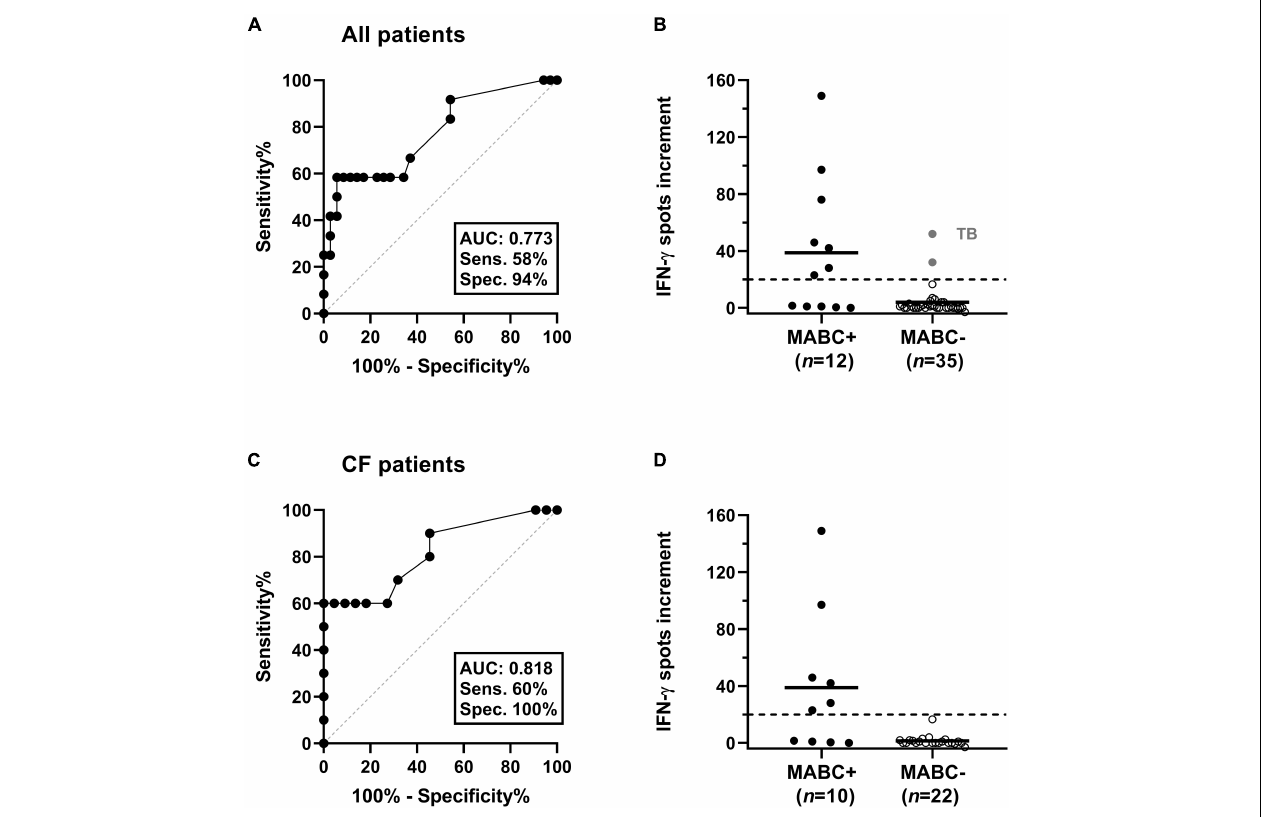
FIGURE 3 | Discrimination between patients with and without M. abscessus (MABC) infection. This analysis considered either all patients (A,B) or only patients with cystic fibrosis (CF) (C,D) . (A,C) Results of receiver operating characteristic (ROC) curve analyses. It was analyzed if ELISpot responses to the MAB_0405c protein were predictive of (culture-confirmed) MABC infection. (B,D) Responses of the MAB_0405c ELISpot are compared in patients with and without MABC infection (Mann–Whitney U test). Positive results in two patients with M. tuberculosis infection (TB) are shown as gray filled circles. The horizontal lines indicate the mean values, and the dashed lines indicate the cut-off value as defined by the ROC curve analysis (20 spots